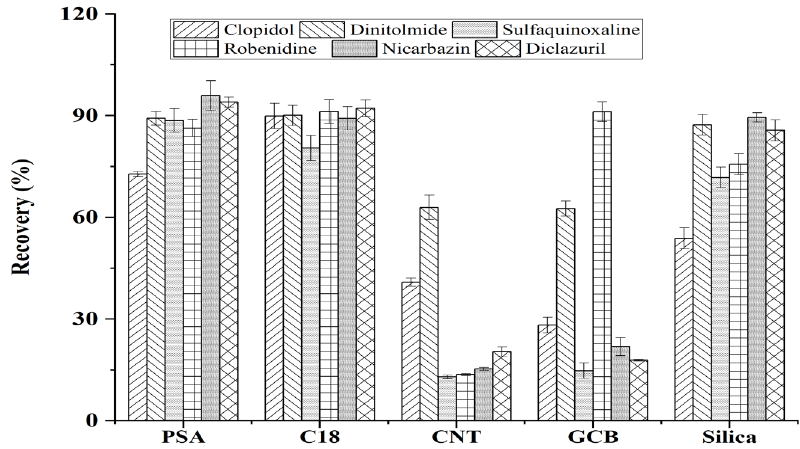
Figure 3. The influence of different commonly used adsorbents including primary secondary amine (PSA), C 18 , graphitized carbon black (GCB), carbon nanotube (CNT), and silica on the recoveries of target compounds (n = 3).